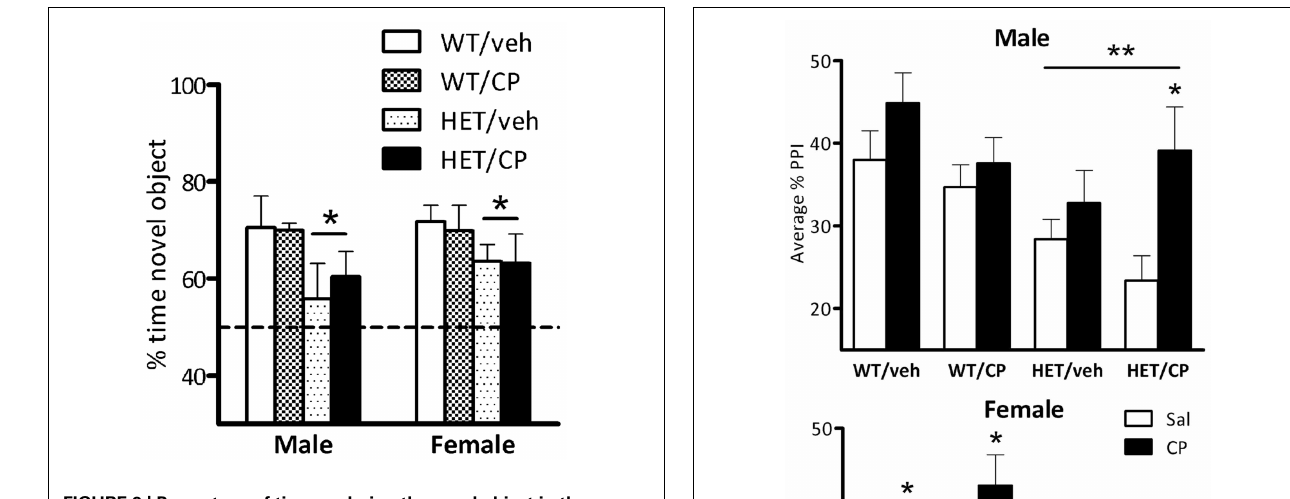
FIGURE 3 | Percentage of time exploring the novel object in the recognition phase of the novel object recognition test. Data are for male and female wild-type (WT) and BDNF heterozygous mice (HET) treated with vehicle (veh) or CP55,940 (CP) and are expressed as mean ± SEM. ∗ P < 0 . 05 for difference between HET mice and wild-type controls based on ANOVA main effect. HET mice spent less time with the novel object compared to wild-type controls but there was no effect of young-adult CP treatment.